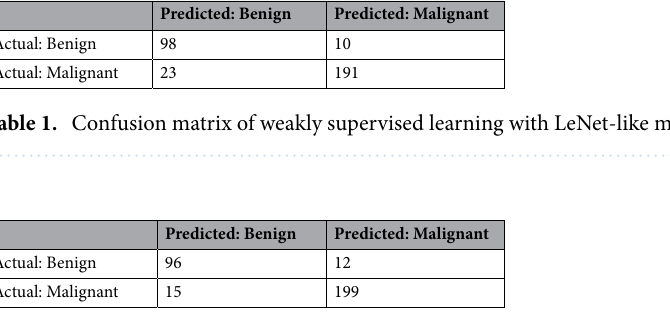
Table 2. Confusion matrix of weakly supervised learning with AlexNet-like model.